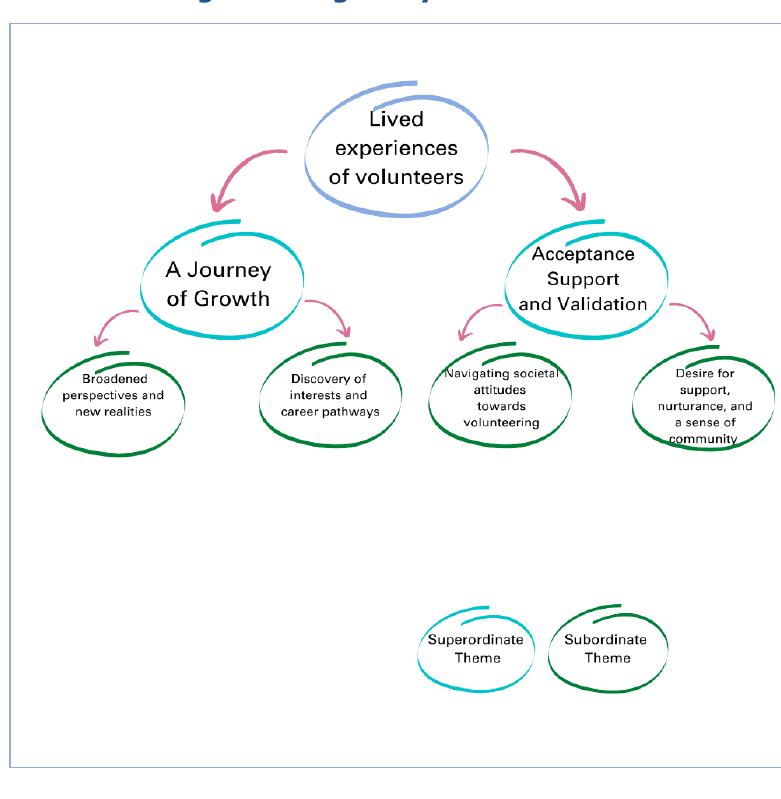
Figure 1. Themes That Emerged During